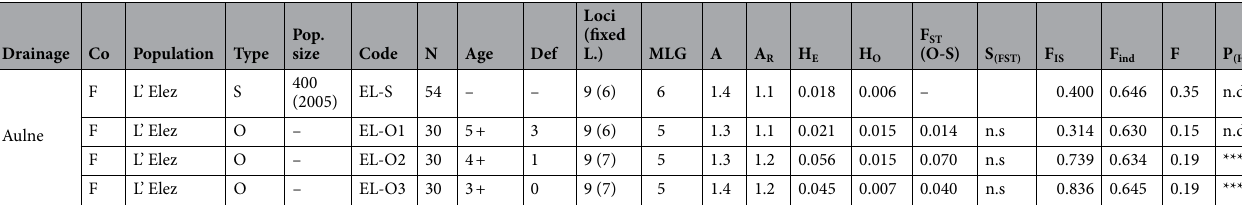
Table 1. Population characteristics and population genetic summary statistics of Margaritifera margaritifera source populations and corresponding cohorts of propagated juveniles. Drainage, country of source population (Co.; D = Germany, A = Austria, B = Belgium, F = France), population (waterbody), population type (S = source population, O = offspring cohort), estimated population size (year of estimation), population code, sample size (N), age of propagated mussels at the time of genetic sampling, number of morphologically deformed specimens in the sample (Def.), number of genotyped microsatellite loci and number of fixed loci, number of distinct multilocus genotypes (MLG), mean number of alleles per locus (A), mean allelic richness per population (A R ), expected and observed heterozygosity (H E , H O ), F ST -value between offspring cohorts and corresponding parent populations (F ST (O-P)) and respective p -values (P( FST) ), inbreeding coefficient (F IS ), individual inbreeding coefficient (F ind ), F-value based on the 2MOD program (F) and results of Hardy– Weinberg probability tests for deviation from expected Hardy–Weinberg proportions (P (HW) ). Significance levels of all tests after sequential Bonferroni correction 41 : *** P ≤ 0.001, ** P ≤ 0.01, * P ≤ 0.05, n.s. = not significant, n.d. = not